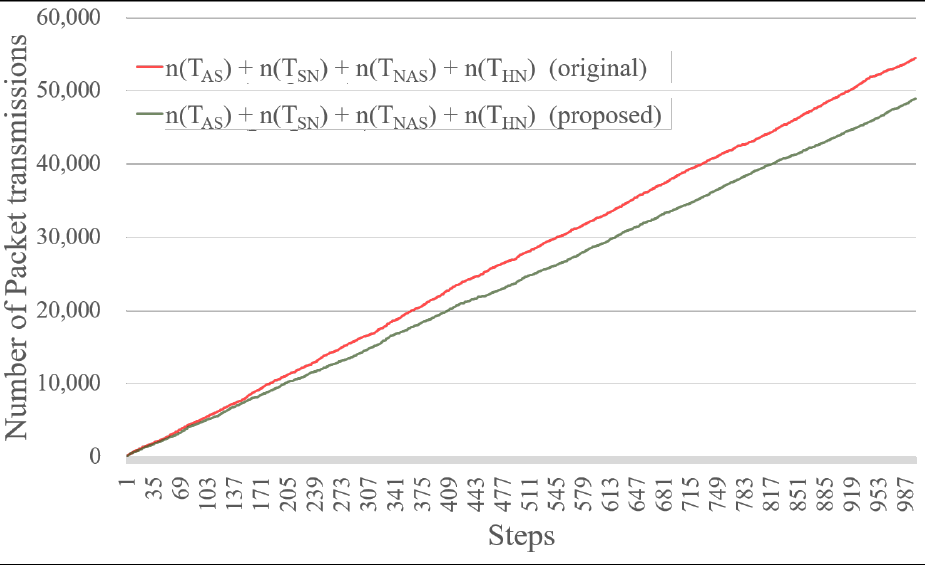
Figure 9. Number of total packets generated in each